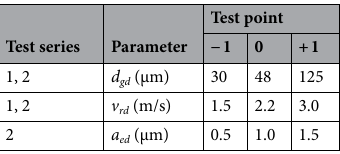
Table 1. Factor levels of test series 2: determining the influence of the dressing parameters on the process parameters.